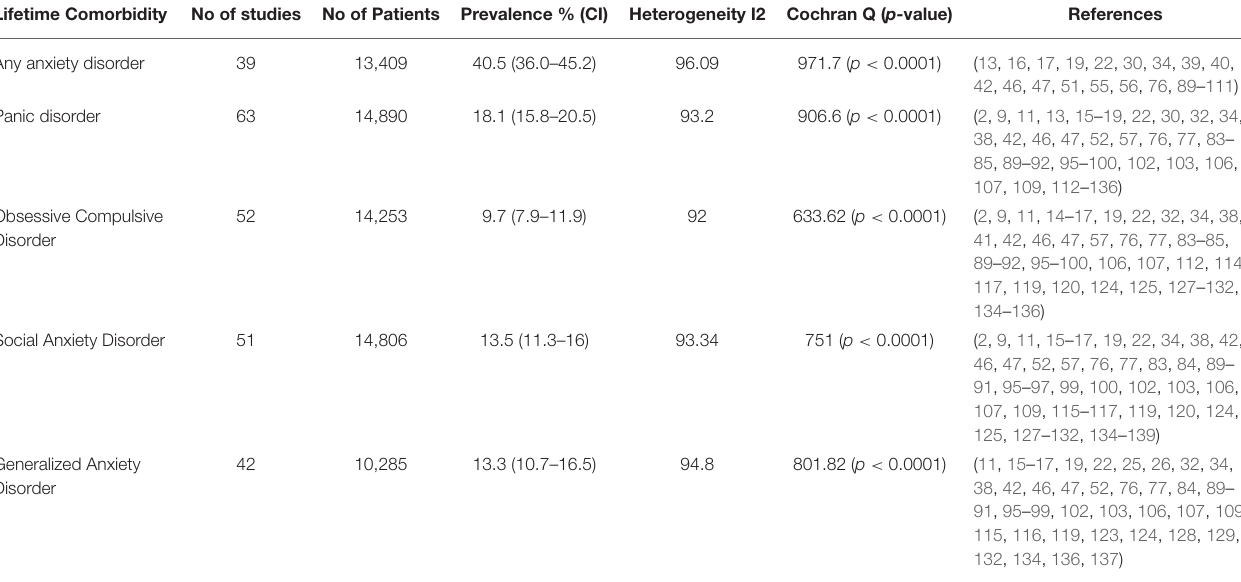
TABLE 1 | Lifetime comorbidity of anxiety disorders in bipolar disorder.